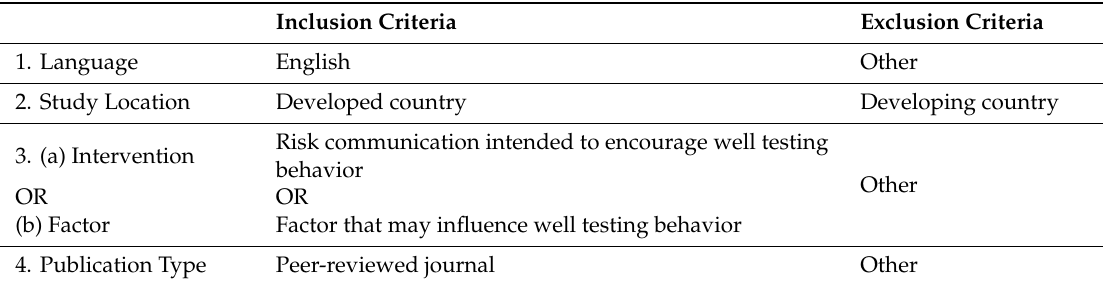
Table 2. Inclusion criteria used in the screening and eligibility